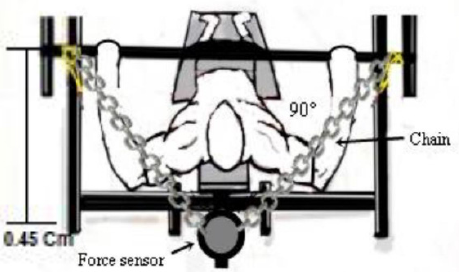
Figure 3. Demonstration of the force sensor